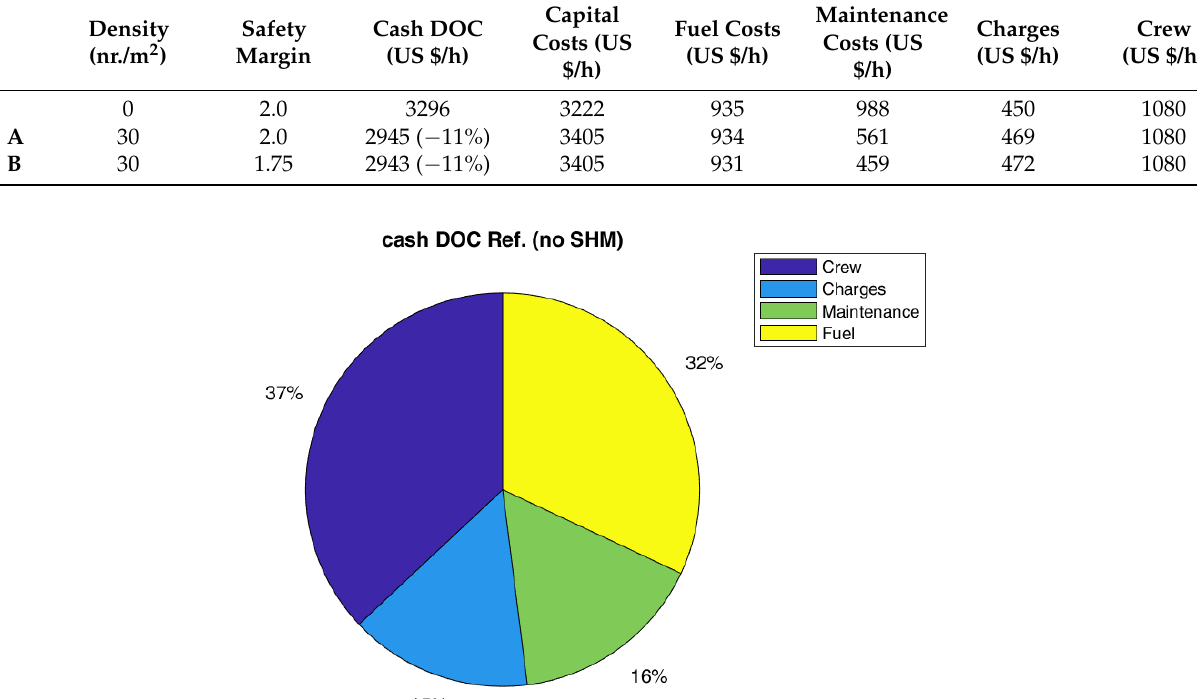
Table 11. Operating Costs breakdown for configurations under consideration.